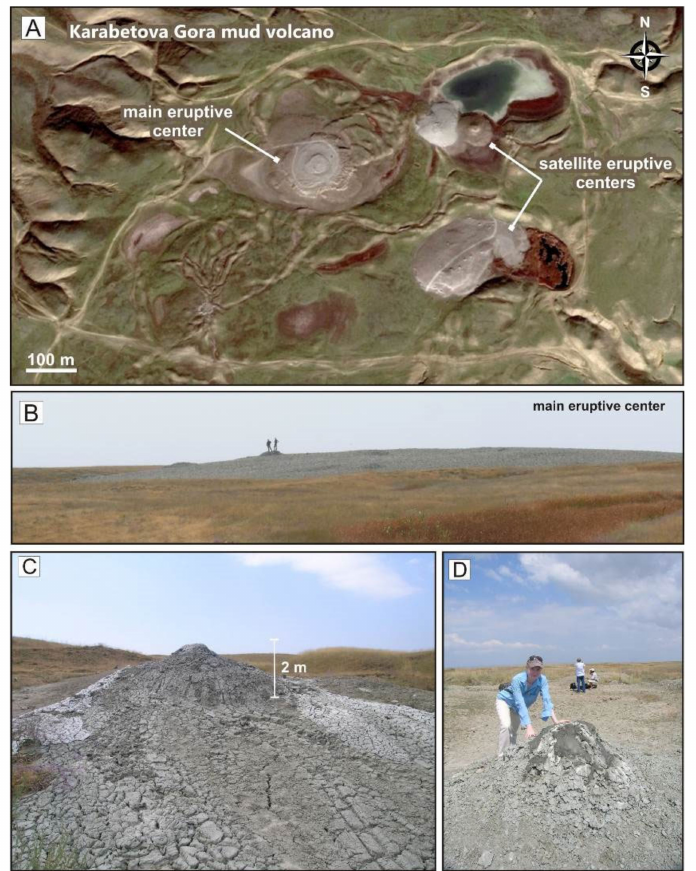
Figure 2. Study area and field view of Karabetova Gora MV, August 2008. ( A ) Panoramic view of Karabetova Gora MV. Google Earth image, 2016 (https://www.google.com/intl/ru/earth/, ac- cessed on 5 December 2022). ( B ) Main eruptive center extruding plastic mud. ( C , D ) Bubbling satellite